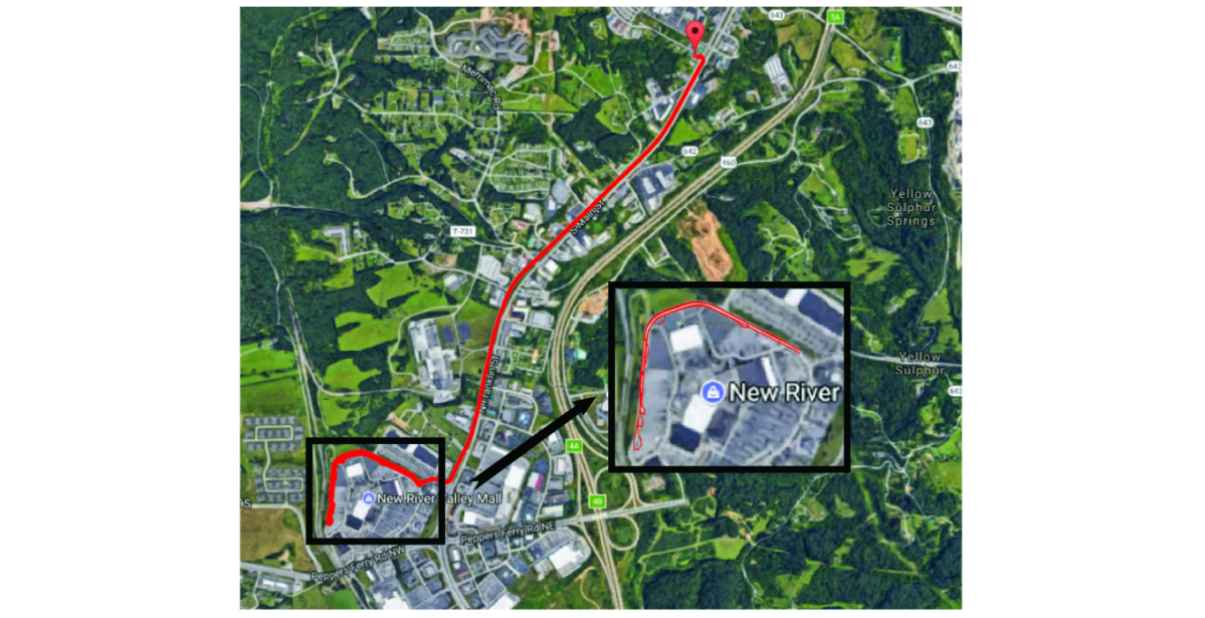
Figure 3. The street-driving phase of the test in Christiansburg, VA. Driving over speedbumps, potholes and U-turns was performed on the loop around New River Valley Mall (black